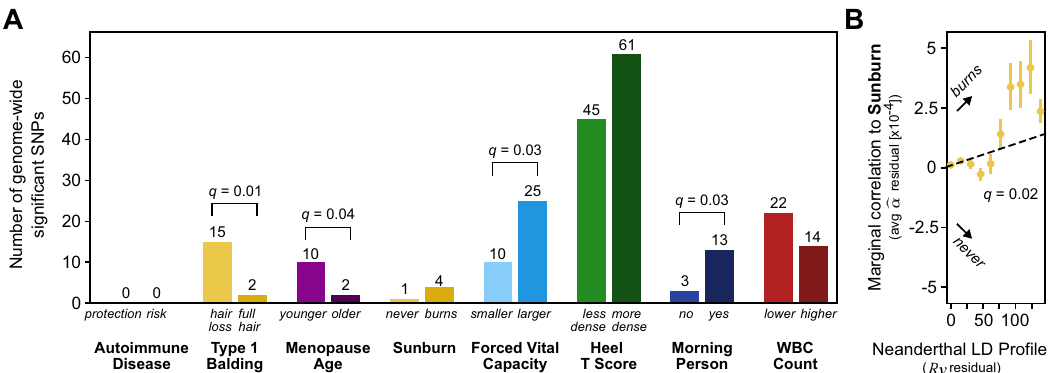
Fig. 3 Neanderthal alleles confer directional effects for some traits. For eight traits with heritability enrichment in Altai-matching introgressed variants (Fig. 1D), we assessed the direction of effect of the Neanderthal alleles with two approaches. The fi rst intersects introgressed Altai-matching Neanderthal alleles (LD-expanded to r 2 = 1) with strongly associated ( P <1×10 − 8 ) variants from each GWAS. A For each trait, we plot the number of variants by the direction of effect of the Neanderthal allele. Variants in perfect LD ( r 2 = 1) are pruned. Four traits show a signi fi cant difference ( q <0.05, one-tailed χ 2 goodness of fi t test ) in the direction of effect: increased balding, younger menopause age, increased forced vital capacity, and morning person. For example, of the 17 Neanderthal alleles associated with balding, 15 are associated with hair loss and only two with full hair. Sunburn, Heel T score, and WBC count also show modest biases. B This second approach, SLDP regression, considers the direction of effect over all variants ( n = 1,187,349), not just those with the largest effects. For each variant, we compute the marginal correlation ( α ̂ ) of the variant to the trait versus the Neanderthal LD pro fi le ( R ν ). For the sunburn trait, we observe a positive correlation indicating a signi fi cant uni-directional relationship genome-wide between Neanderthal introgressed alleles and risk for sunburn (empirical null distribution P = 0.001, q = 0.02). For visualization, we bin R ν into 10 equally spaced intervals and plot the average α ̂ with 95% bootstrapped con fi dence fractures, dental diseases, 1.9-fold enriched, CI: 1.3 – 2.8, q = 0.06),